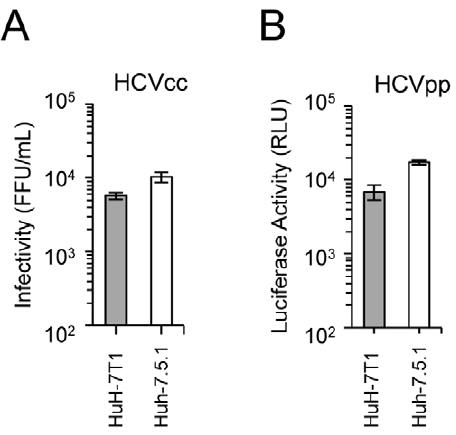
Figure 2. Comparison of infection in HuH-7T1 and Huh-7.5.1. (A) Infection of HCVcc into HuH-7T1 and Huh-7.5.1. The cells were fixed 3 days after infection and infected foci were counted. (B) Infection of HCVpp into HuH-7T1 and Huh-7.5.1. The cells were harvested 3 days after infection, and the luciferase activity in the cell lysate was